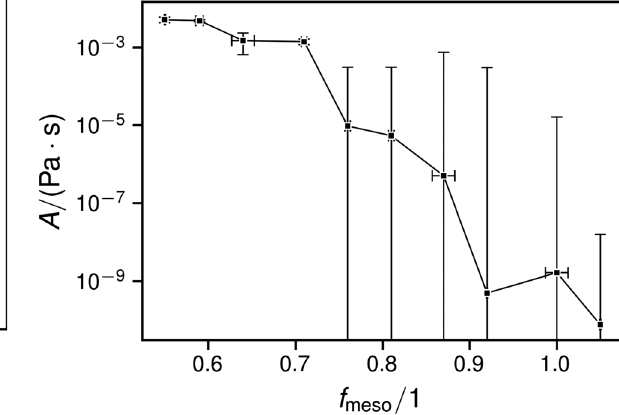
Figure 4: Ratios of the thermal expansion coe ffi cients in the liquid and glassy states.